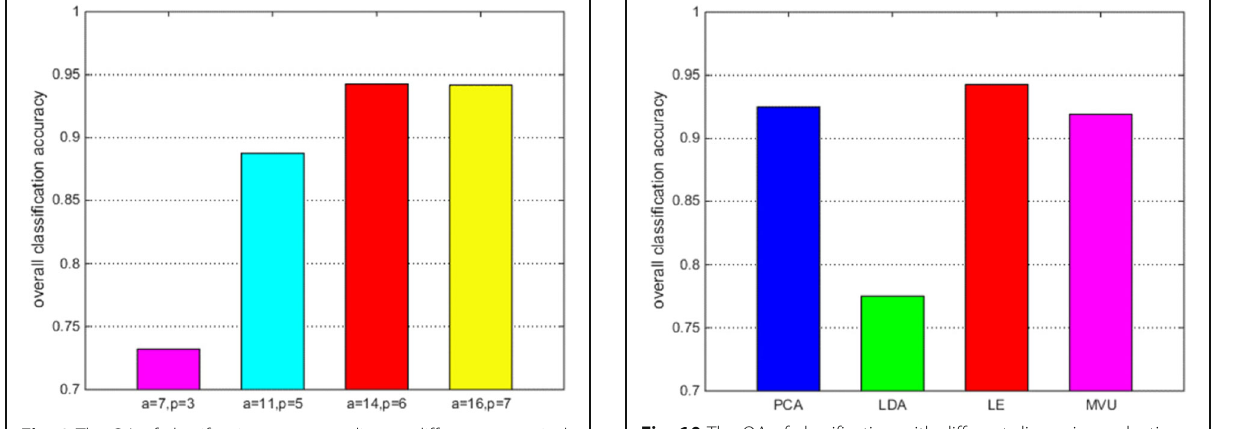
Fig. 8 The OA of classification corresponding to different superpixel generation parameters